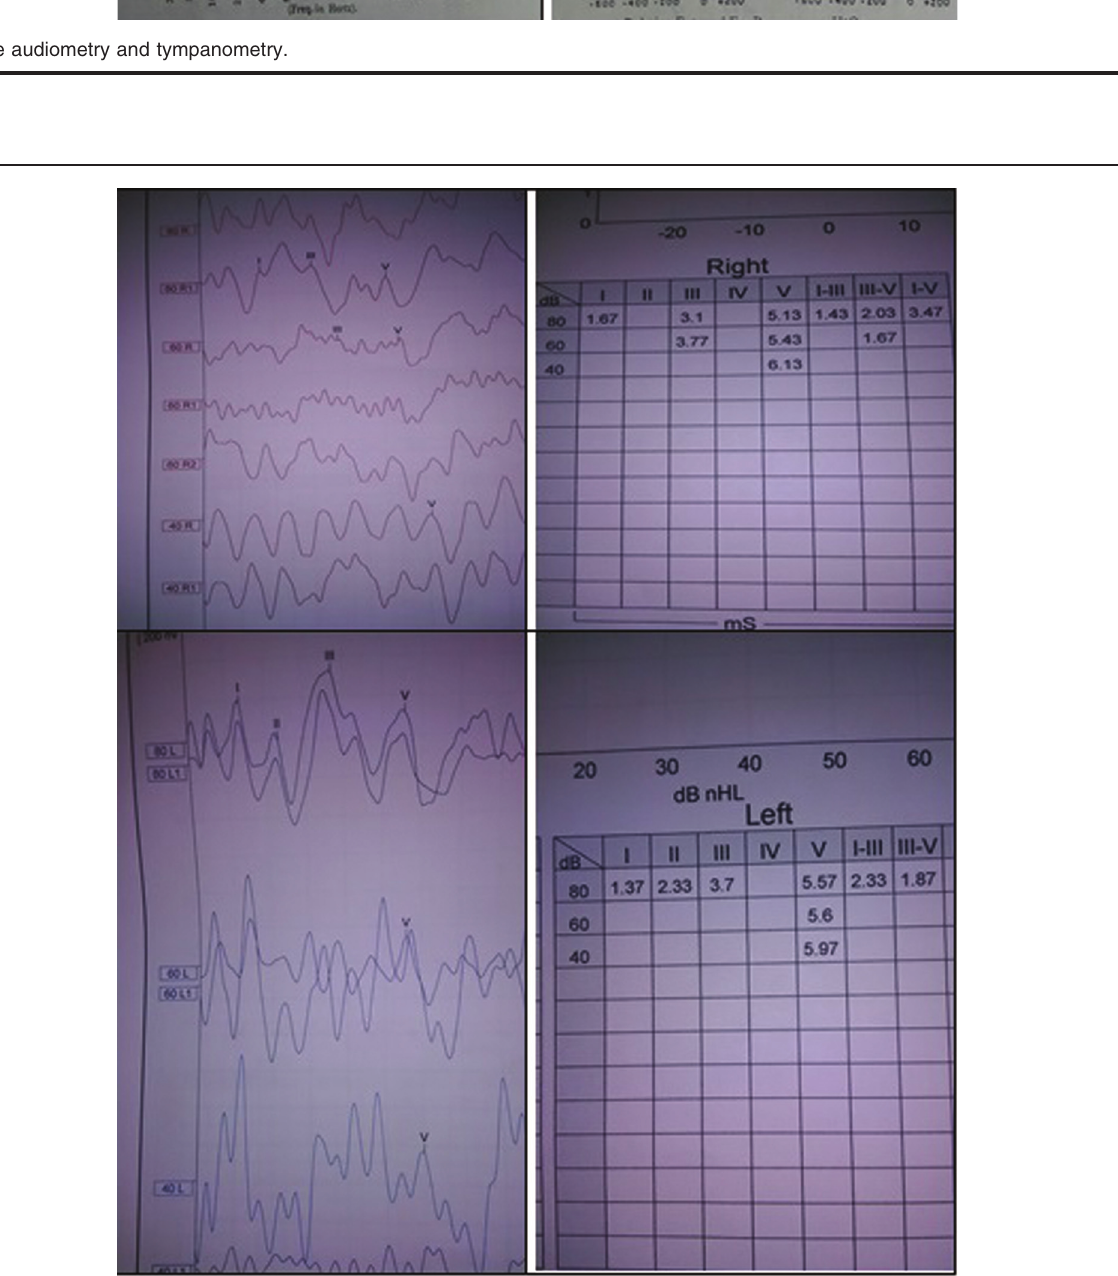
Click-evoked auditory brainstem response in both ears (the child was awake).